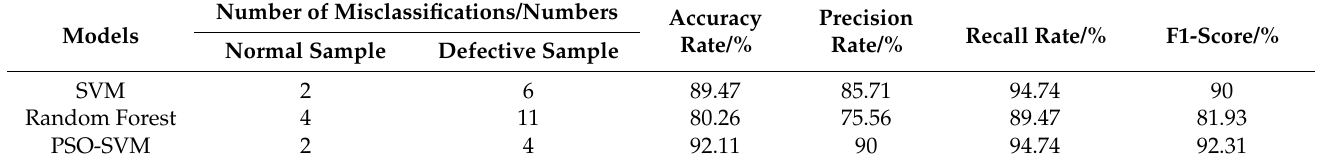
Table 5. Classification results of test sets on different models.